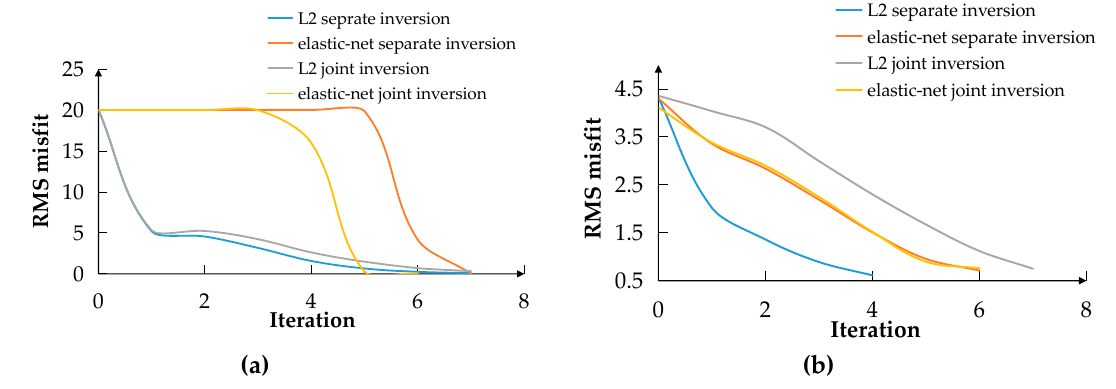
Figure 6. The RMS misfit evolution of the MT inversion ( a ) and gravity inversion ( b ).